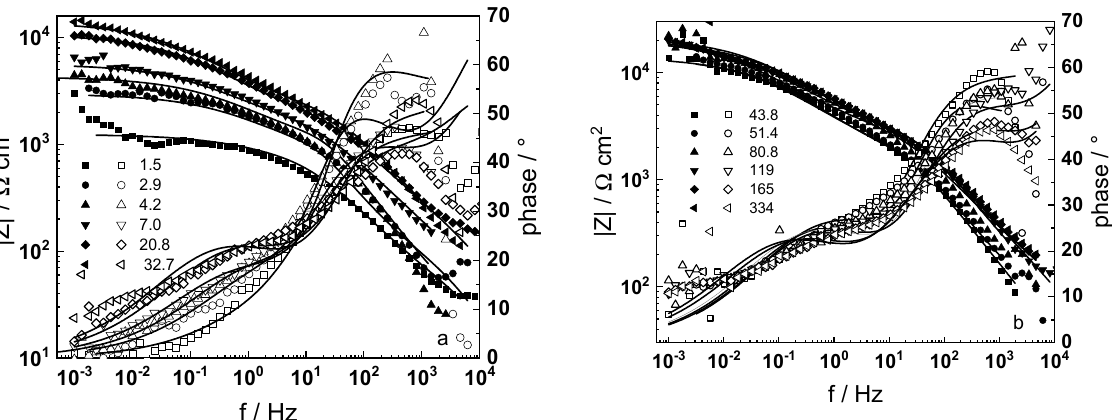
Figure 3. Electrochemical impedance spectra of ex-situ pre-hydrogenated sample in WWER coolant without LiOH at 300 ◦ C depending on the oxidation time. Left ordinate-impedance magnitude (full symbols) and phase shift (open symbols) vs. frequency. Points-experimental data, solid lines-best-fit calculation. The legend gives oxidation time in h.